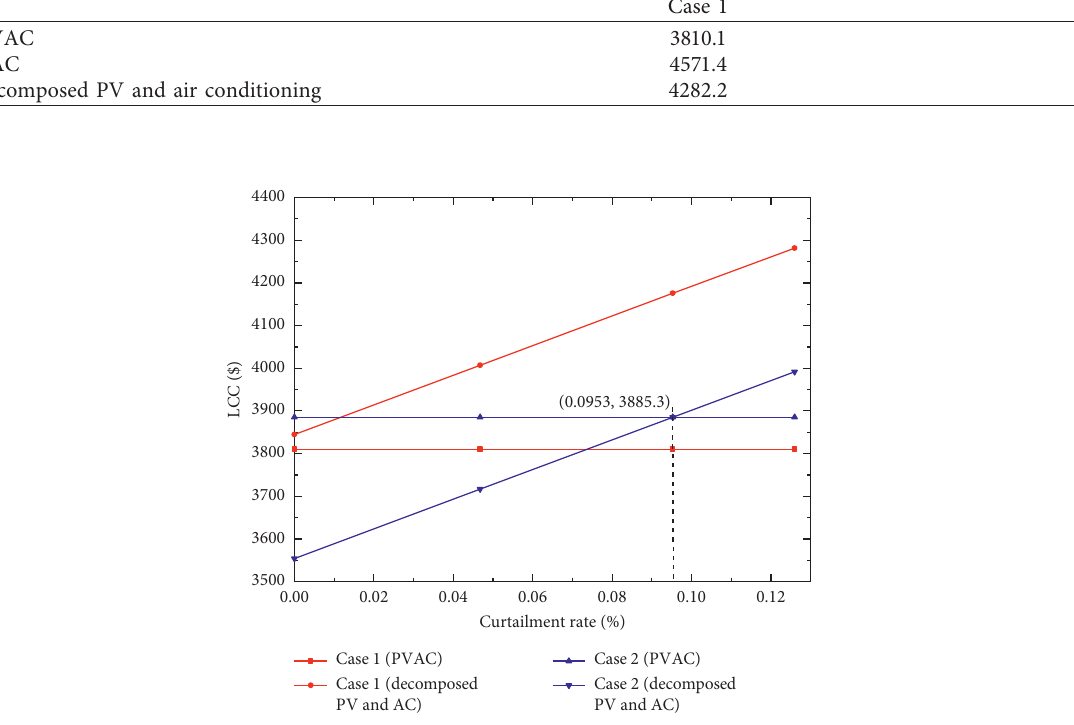
Figure 9: LCC comparison between decomposed PV and air conditioning and TAC considering the curtailment rate of case 1.